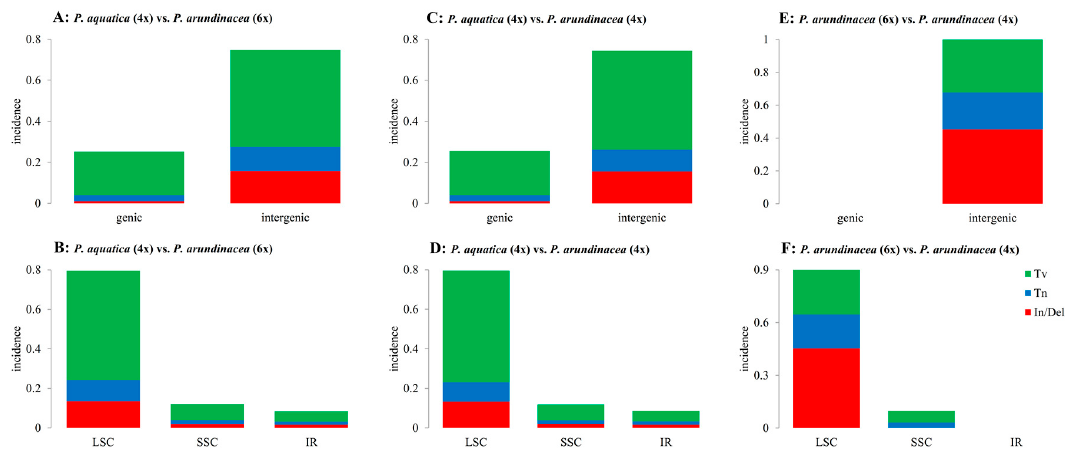
Figure 3. Summary of single nucleotide polymorphisms (SNPs) and indels. Tv, transversion; Tn, transition; In/Del, insertion and deletion; LSC, large single-copy region; SSC, small single-copy region; IR, inverted repeat region; ( A , B ), ( C , D ), and ( E , F ) reflect differences between P. aquatica (4x) vs. P. arundinacea (6x), P. aquatica (4x) vs. P. arundinacea (4x), and P. arundinacea (6x) vs. P. arundinacea (4x), respectively.